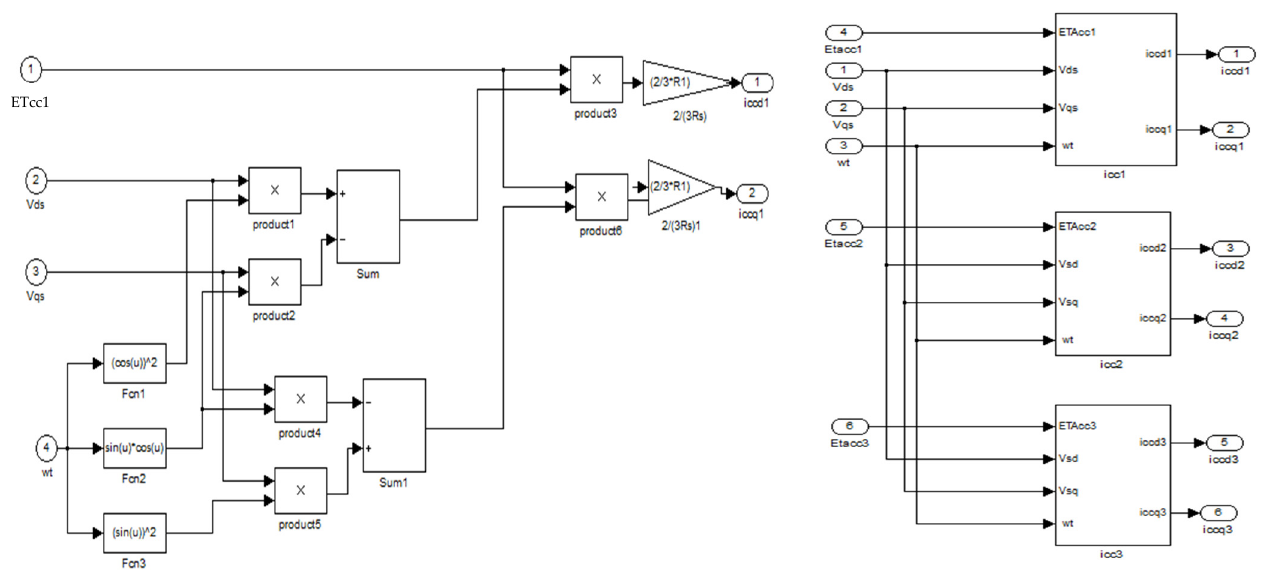
Figure 4. Simulink block diagram of the inter-turn.